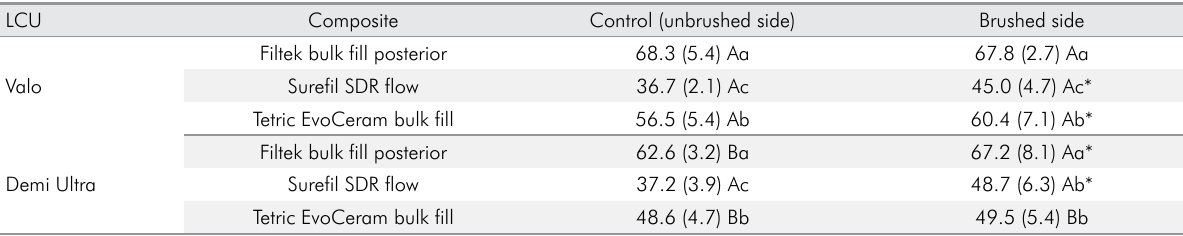
Table 5. Mean (±SD) Knoop microhardness (KHN).